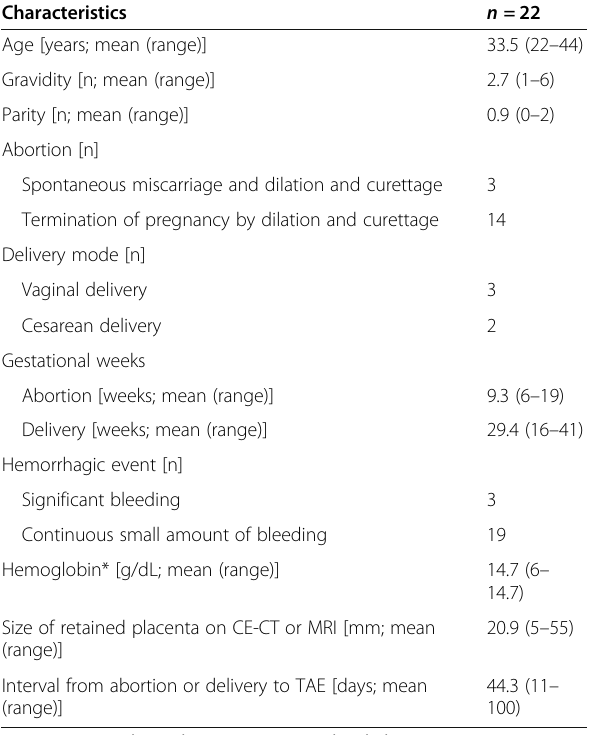
Table 1 Characteristics of 22 women with vaginal hemorrhage due to retained